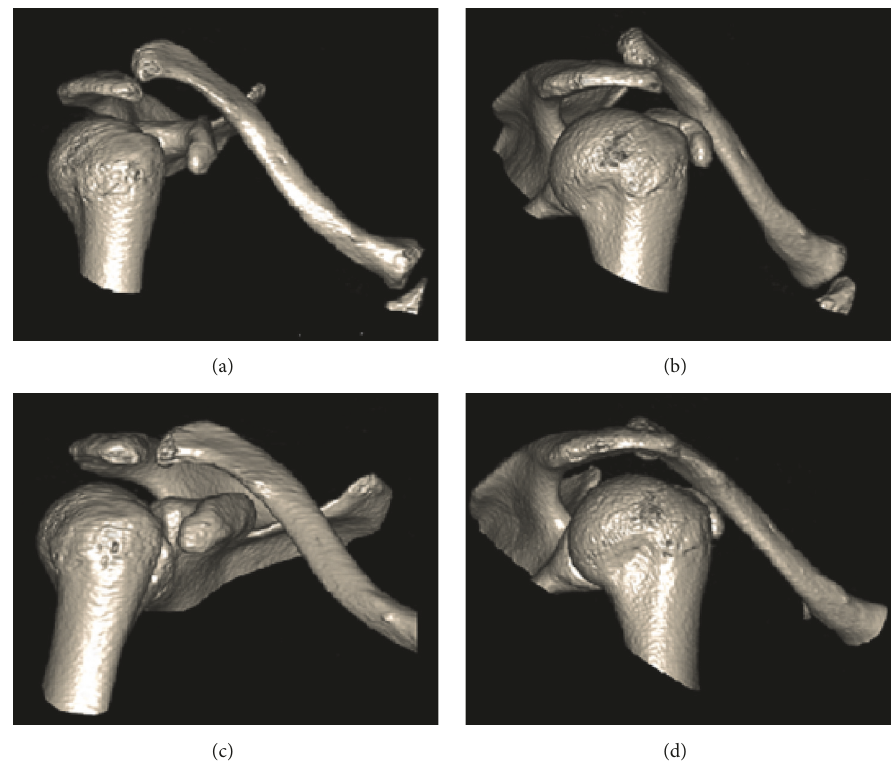
Figure 1: 3D-CT scan after the patient created a dislocation ((a) and (b)) and after the patient created a comfortable situation ((c) and